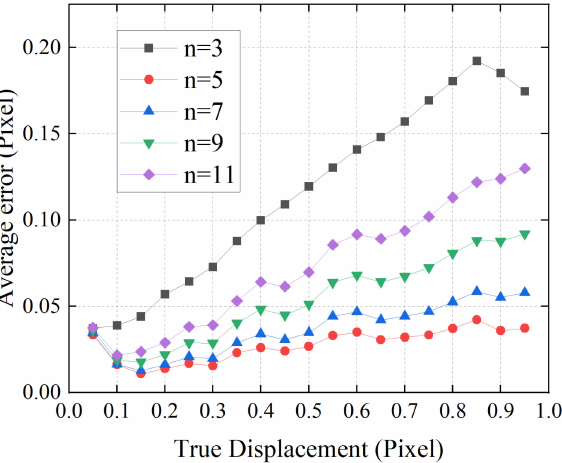
Figure 4. Dependence of the average error result on the shift amount for different quadratic polyno- mial fitting kernel